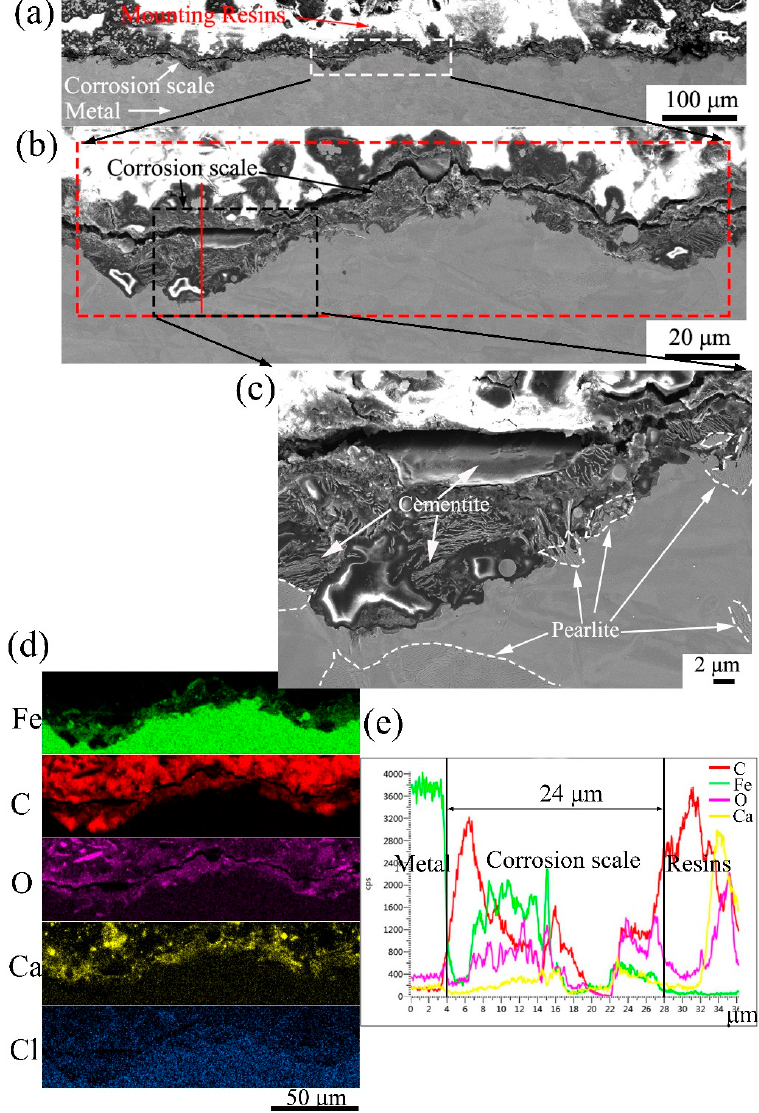
Figure 9. ( a ) SEM image of a cross-section of L245N standard steel after 4 days of testing; ( b ) the enlarged SEM image of the area in the white box in ( a ); ( c ) the more enlarged SEM image of the area in the black box marked in ( b ); ( d ) EDS mapping of the area in the red box in ( b ) and ( e ) EDS compositional profile along the red line marked in ( b ).